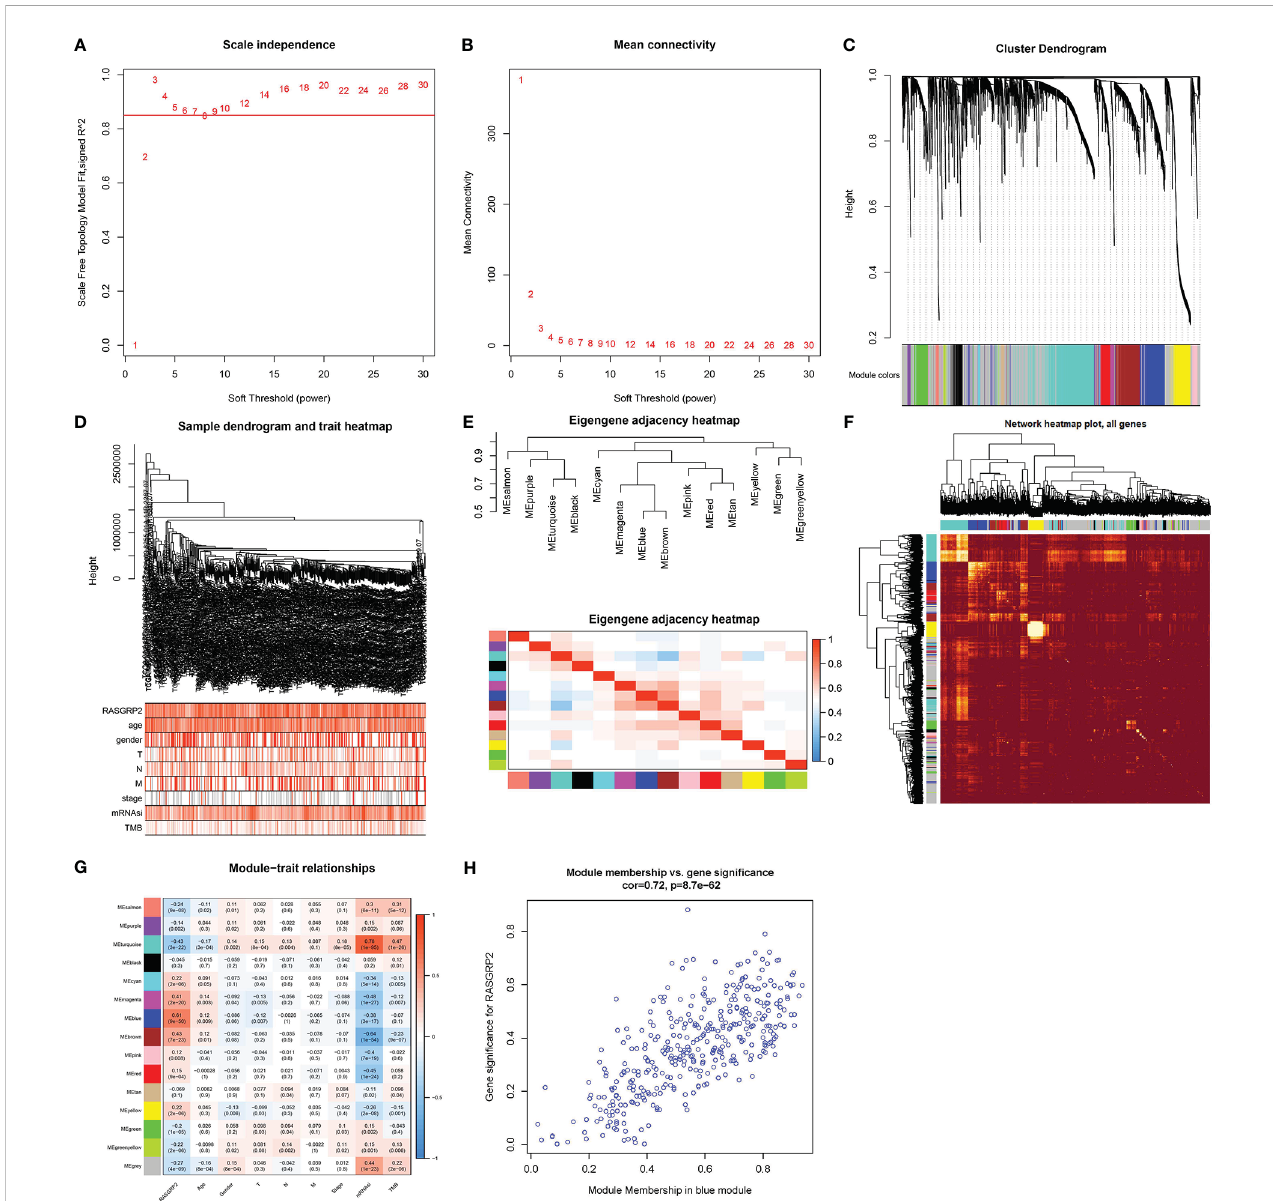
FIGURE 6 Screening for RASGRP2-related modules and genes in LUAD. (A, B) Calculation of the scale-free fi t index of various soft-thresholding powers ( b ) and analysis of the mean connectivity of various soft-thresholding powers ( b ). (C – F) Cluster dendrogram of LUAD patients. According to the dissimilarity measure (1-TOM), 473 were clustered into 15 modules. (G) The correlation heatmap between clinicopathological parameters and modules when RASGRP2 was the research object of LUAD. (H) Scatter plot of the blue